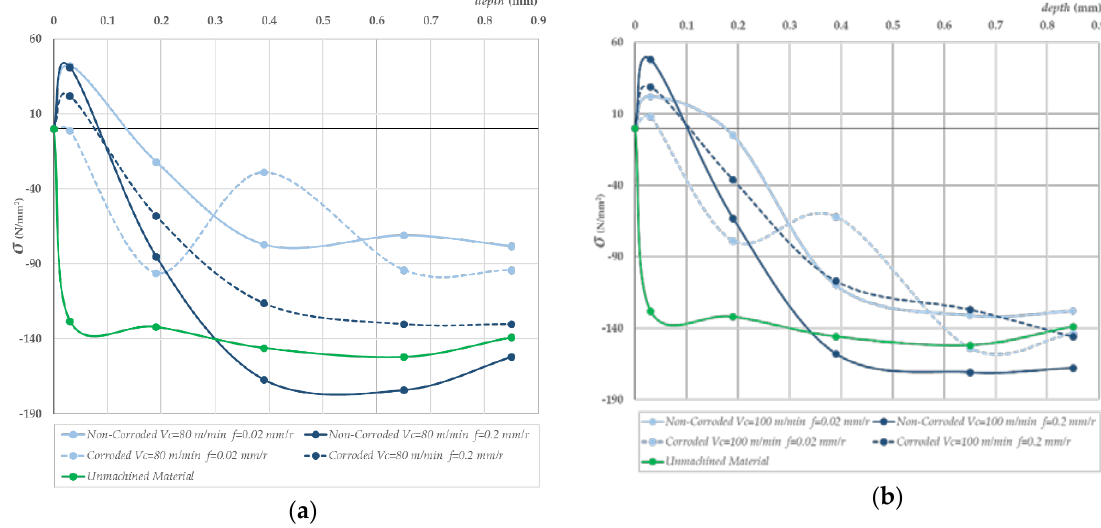
Figure 8. Evolution of axial residual stress/depth after machining for the cutting parameters indicated in noncorroded and corroded specimens. ( a ) Vc = 80 mm/min, ( b ) Vc = 100 mm/min. Two feed rates shown in both cases, f = 0.02 mm/r and f = 0.2 mm/r.